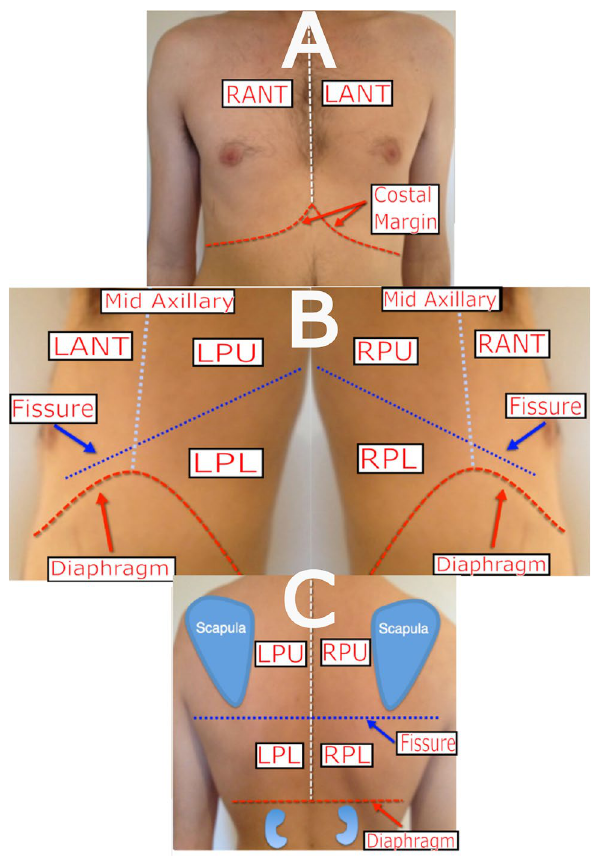
Figure 1. Describes the scanning locations: ( A ) Right Anterior (RANT) and Left Anterior (LANT); ( B ) Left Posterior Upper (LPU), Left Posterior Lower (LPL), Right Posterior Upper (RPU), and Right Posterior Lower (RPL); ( C ) Posterior view for LPU, RPU, RPL and LPL Source: Adapted from 30